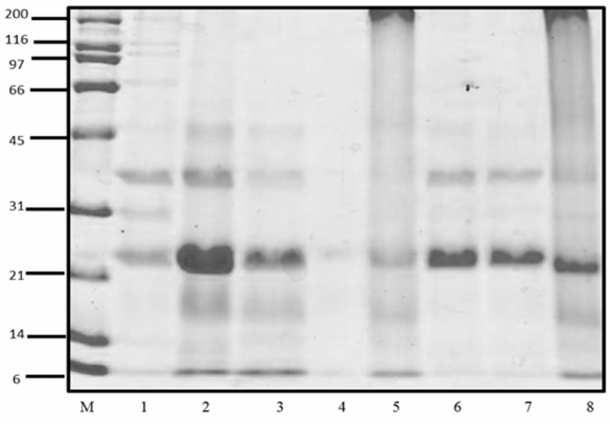
Figure 1. SDS-PAGE profiles of cacao protein (CP) fractions. M): molecular weight